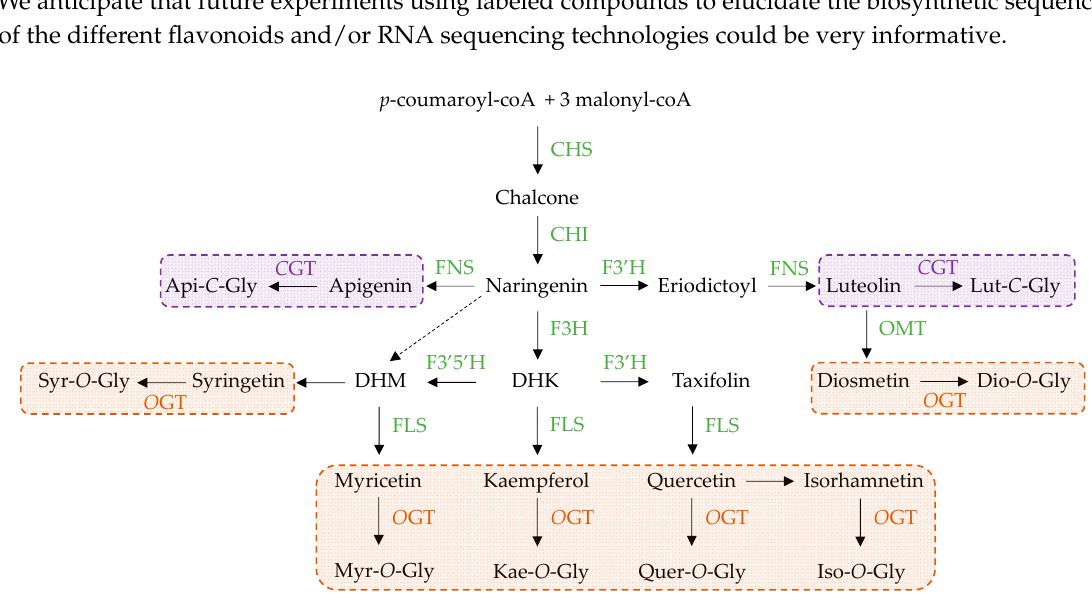
Figure 5. Proposed biosynthetic sequence of FOGs (orange) and FCGs (purple) derived flavonoids from Nelumbo nucifera adapted from Li et al. (2014). CHS, chalcone synthase; CHI, chalcone isomerase; FNS, flavone synthase; F3H, flavanone 3 hydroxylase; F3 ′ H, flavonoid 3 ′ hydroxylase; F3 ′ 5 ′ H, flavonoid 3 ′ ,5 ′ hydroxylase; FLS, flavonol synthase; O GT, O -flavonoid glycosyltransferase; CGT, C - flavonoid glycosyltransferase; Api, apigenin; DHM, dihydromyricetin; DHK, dihydrokaempferol; Myr, myricetin; Kae, kaempferol; Quer, quercetin; Iso, isorhamnetin; Dio, diosmetin; Lut, luteolin; Syr, syringetin; Gly, glycoside(s).